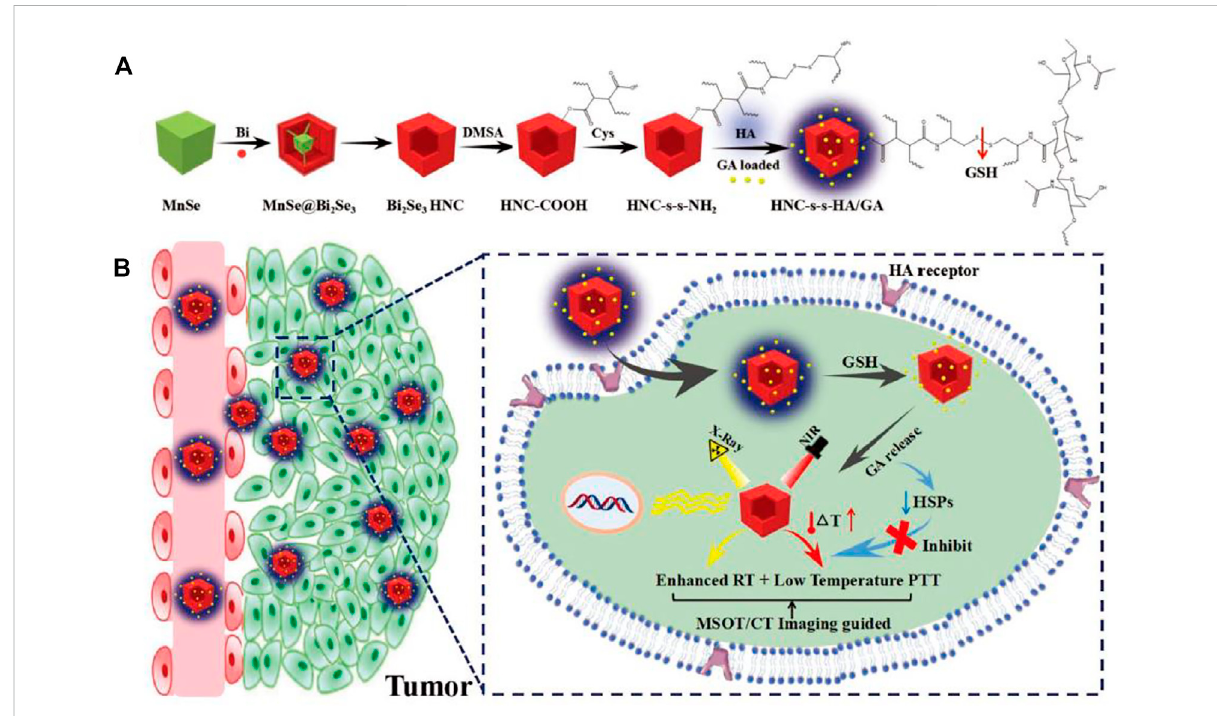
FIGURE 1 Schematicdiagramof (A) theconstructionofBi2Se3HNC-s-s-HA/GA(HNC-s-s-HA/GA), (B) HNC-s-s-HA/GAprovokedlow-temperaturePTT and boosted RT (Song et al.,